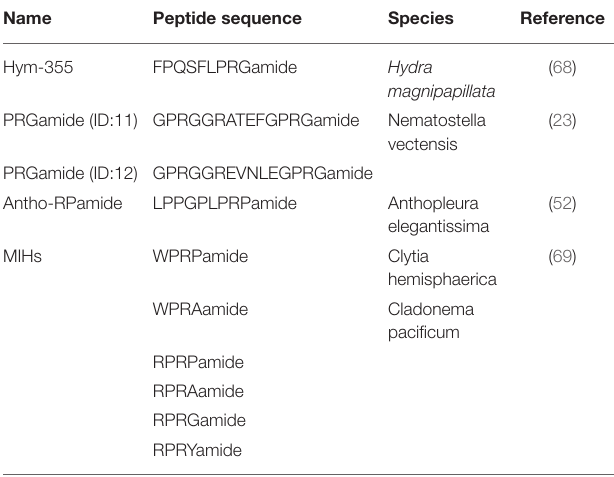
Frontiers in Endocrinology |